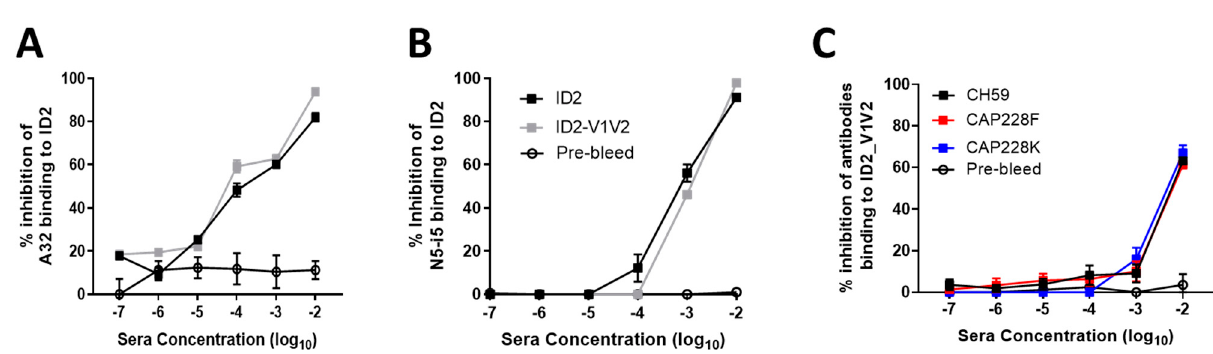
Figure 4. Competition ELISA. Sera from mice immunized with ID2 (grey) or ID2 + ID2-V1V2 were assessed for competition, with ( A ) A32 and ( B ) N5-i5 against plate-bound ID2. ( C ) Sera from ID2-V1V2-immunized mice were assessed for competition, with CH59, CAP-228F and CAP-228K against plate-bound ID2-V1V2.